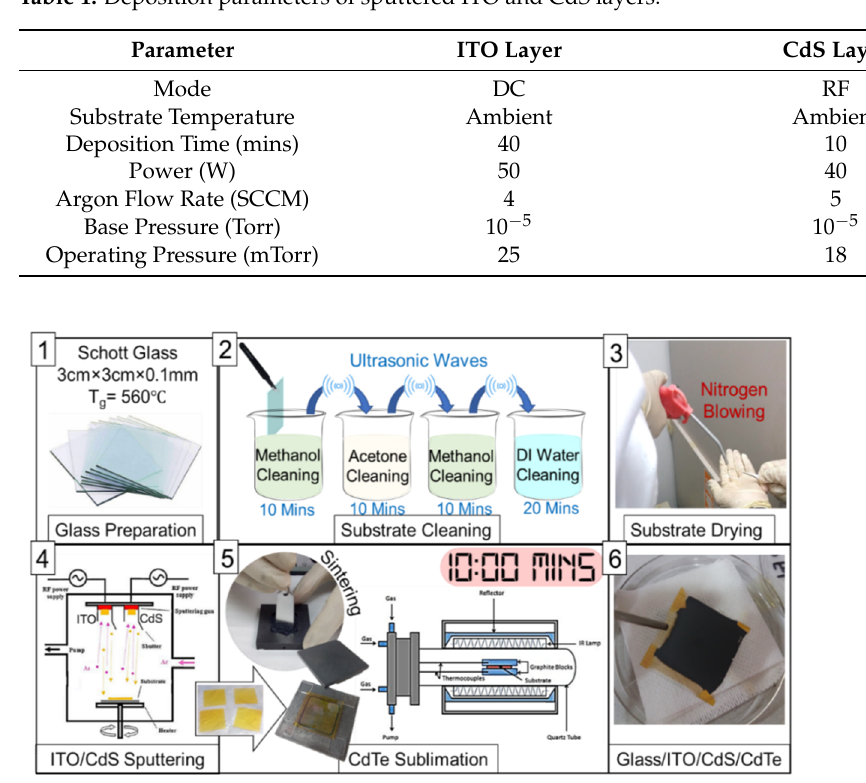
Figure 2. Schematic of the complete process of film preparation, ( 1 ) Glass preparation, ( 2 ) sub- Schematic of the complete process of film preparation, ( 1 ) Glass strate cleaning, ( 3 ) Substrate drying, ( 4 ) ITO/CdS sputtering, ( 5 ) CdTe Sublimation, ( 6 ) Glass/ITO/CdS/CdTe.